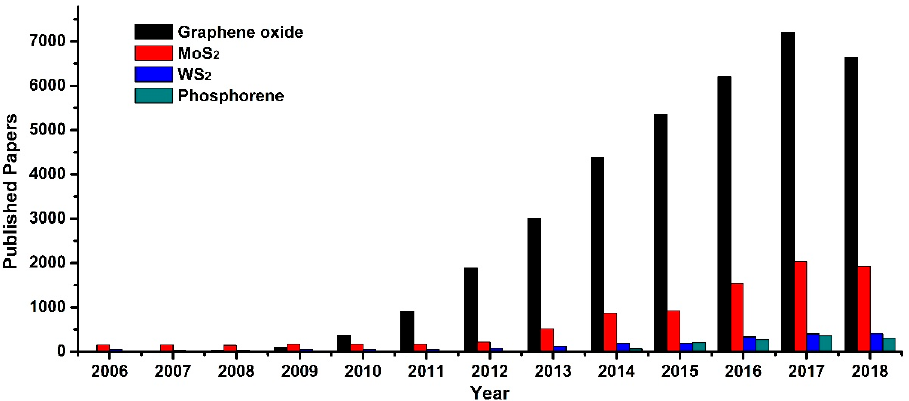
Figure 1. Number of published papers vs. year of publication for “graphene oxide”, “MoS 2 ”, “WS 2 ” and “phosphorene” or “exfoliated black phosphorus”. (Source: Scopus, 28 September 2018).